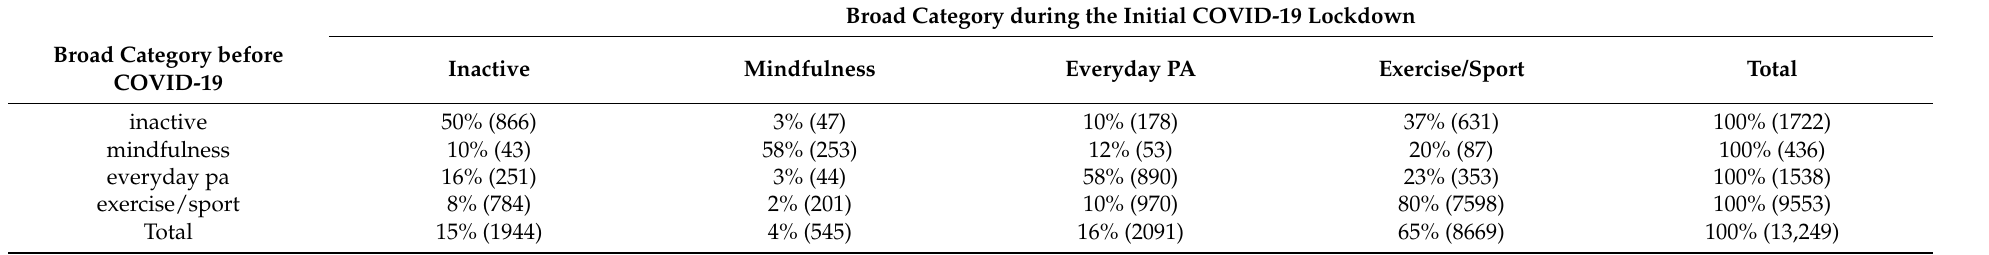
Table A2. Change in type of exercise (broad categories) including exact numbers and percentages.